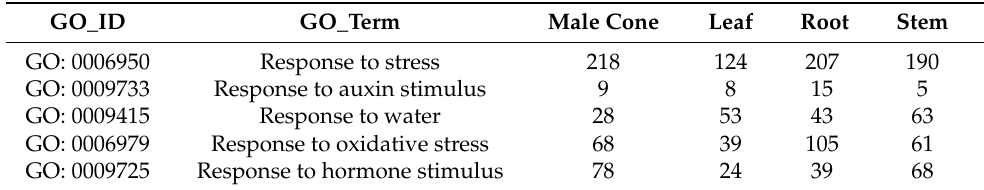
Table 2. The number of genes of the third-level Gene Ontology (GO) terms from “response to stimulus” in each